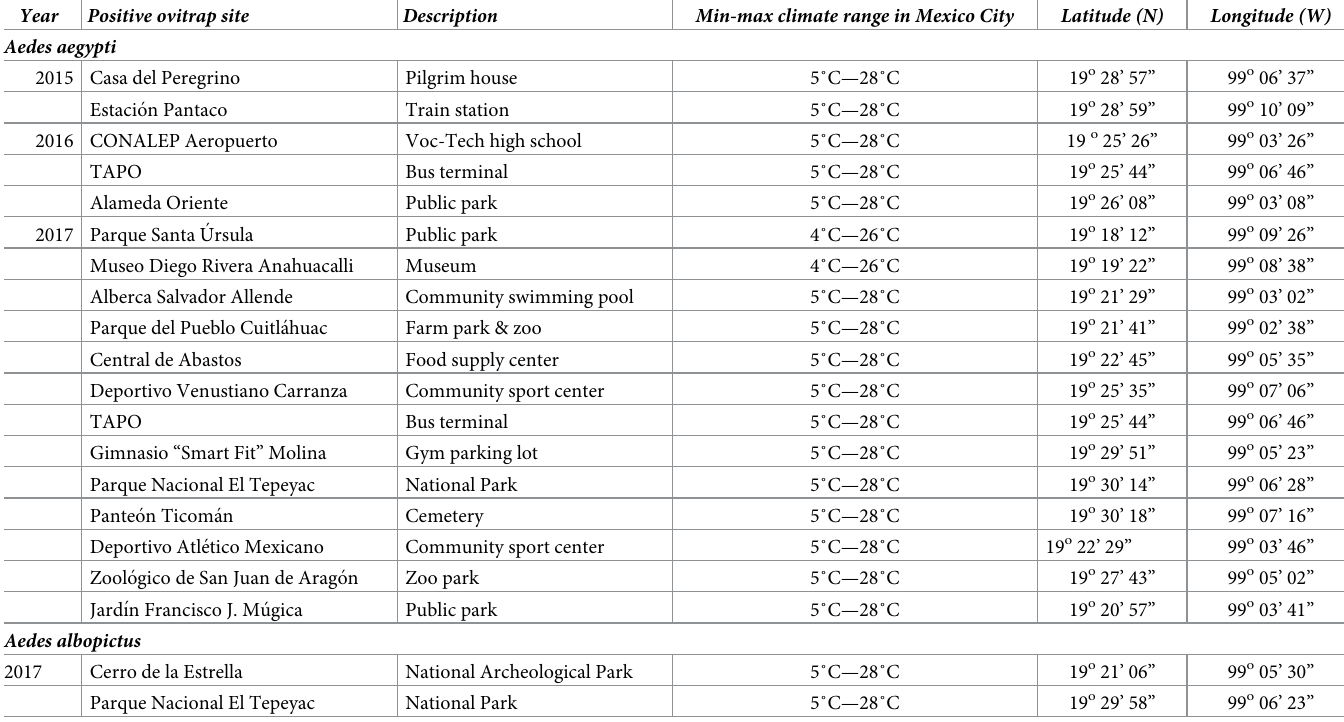
Table 4. Location of Aedes aegypti and Aedes albopictus eggs collected by ovitraps in Mexico city.